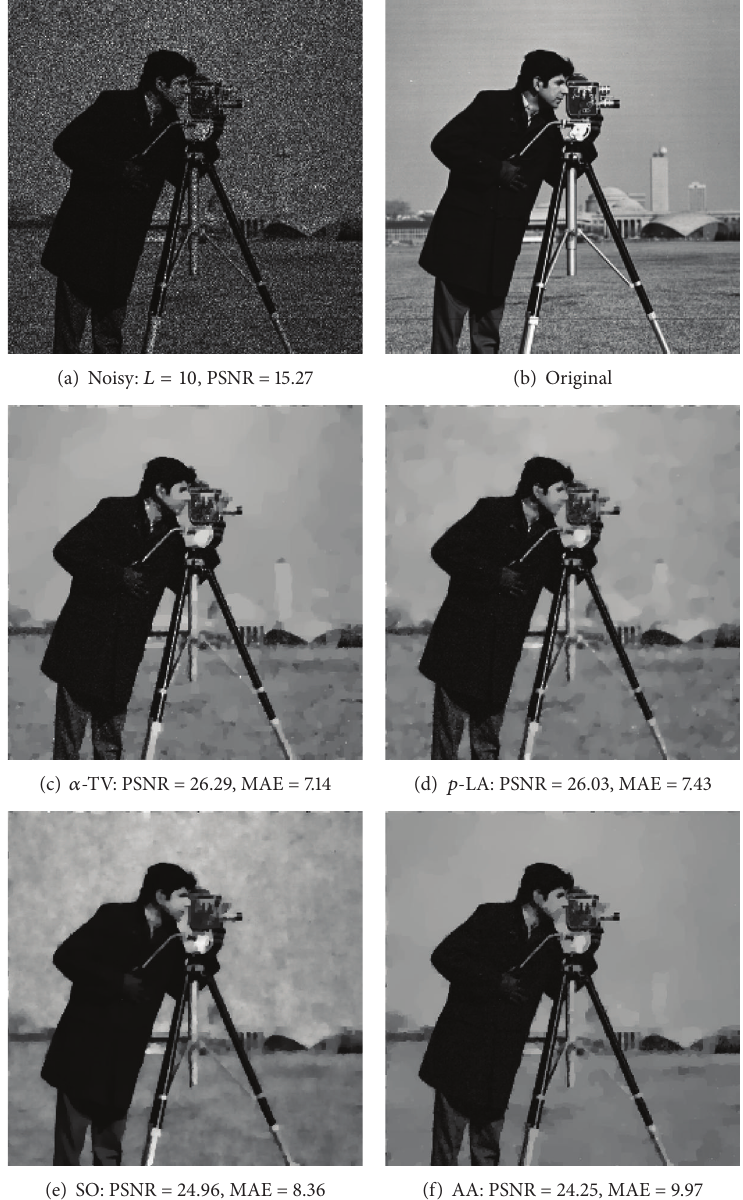
Figure 10: Cameraman image ( 512 × 512 ). (a) Noisy image corrupted by speckle noise for 𝐿 = 10 in (8). (b) Original image. (c) Our algorithm by 𝛼 -TV, 𝜎 = 8/6 , 𝑘 = 0.005 , and 𝜏 = 0.05 . (d) Our algorithm by 𝑝 -LA, 𝑝 𝑈 = 1.2 . (e) SO algorithm, 𝜆 = 1 , 𝛼 = 0.25 . (f) AA algorithm, 𝜆 = 390